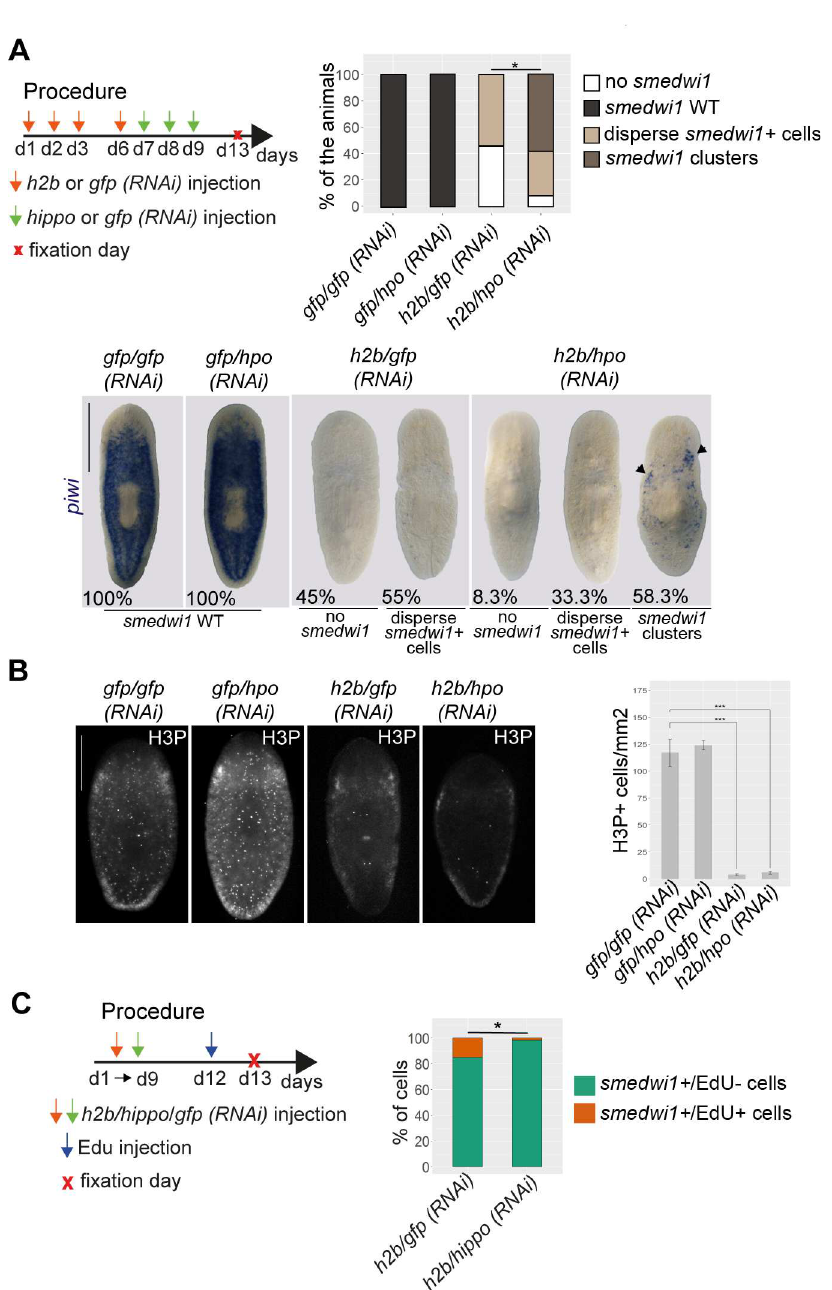
Fig 6. hippo maintains the differentiated state in planarians. (A) Cartoon illustrating the experimental design of the hippo RNAi experiment in neoblast-depleted animals. ISH for smedwi-1 in the 4 RNAi conditions and corresponding quantification of smedwi-1 expression distribution and classification in 4 categories ( n (cid:21) 10). Black arrows indicate smedwi-1+ clusters. Data were analyzed by chi-squared test, applying a Bonferroni correction ( (cid:3) p < 0.01). (B) Immunostaining of h2b/hippo (RNAi) animals and corresponding controls with anti-H3P antibody, and corresponding quantification. The total number of H3P+ cells in the whole animal was quantified and normalized with respect to total body area. Error bars represent standard deviation ( n (cid:21) 14). Data were analyzed using a Student t test ( (cid:3)(cid:3)(cid:3) p < 0.001). Scale bars: 1 mm (A). (C) EdU incorporation followed by FISH of smedwi-1 in h2b (RNAi) and h2b/hippo (RNAi) animals. The procedure used and the corresponding quantification of smedwi-1+/ EdU-and smedwi-1+/ Edu+cells are shown. In total, 15 sections corresponding to n (cid:21) 8 animals were analyzed. Data were analyzed by chi-squared test, applying a Bonferroni correction ( (cid:3) p < 0.01). Data used in the generation of this figure can be found in S1 Data. EdU, 5-ethynyl-2 0 -deoxyuridine; FISH, fluorescent in situ hybridization; gfp ,green fluorescent protein; hpo , hippo ; H3P, phospho-histone-H3-Ser10; ISH, in situ hybridization; RNAi, RNA interference.